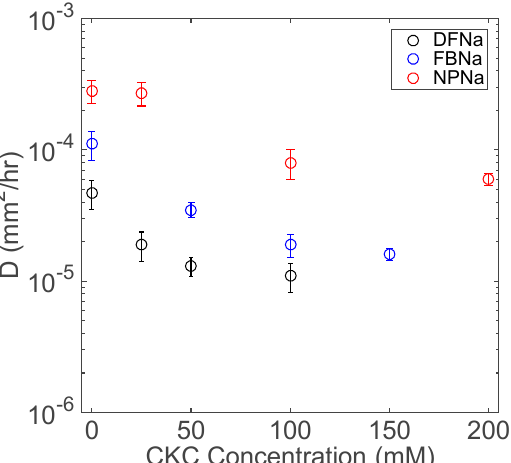
Figure 8. Fitted values of drug diffusivities at determined CKC concentrations for each of the three tested drugs. Data are presented as mean ± standard deviation with n = 3.